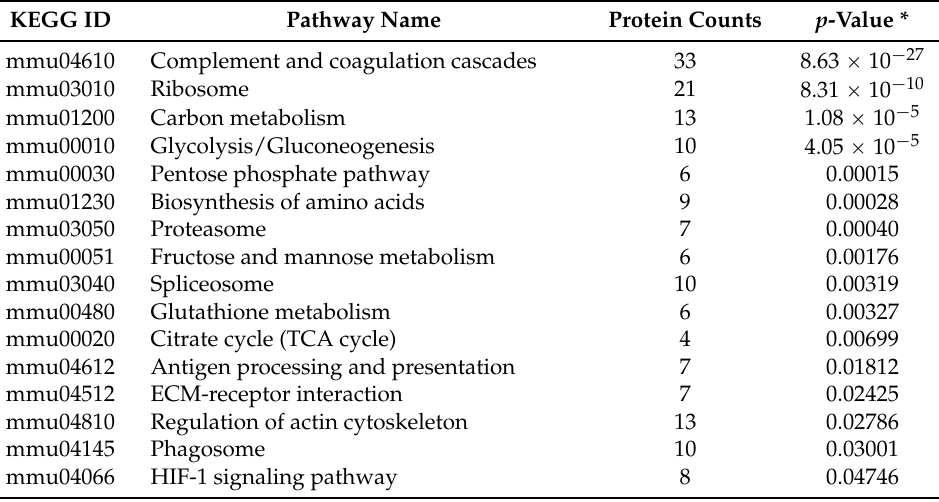
Table 2. The KEGG pathway analysis of BFF